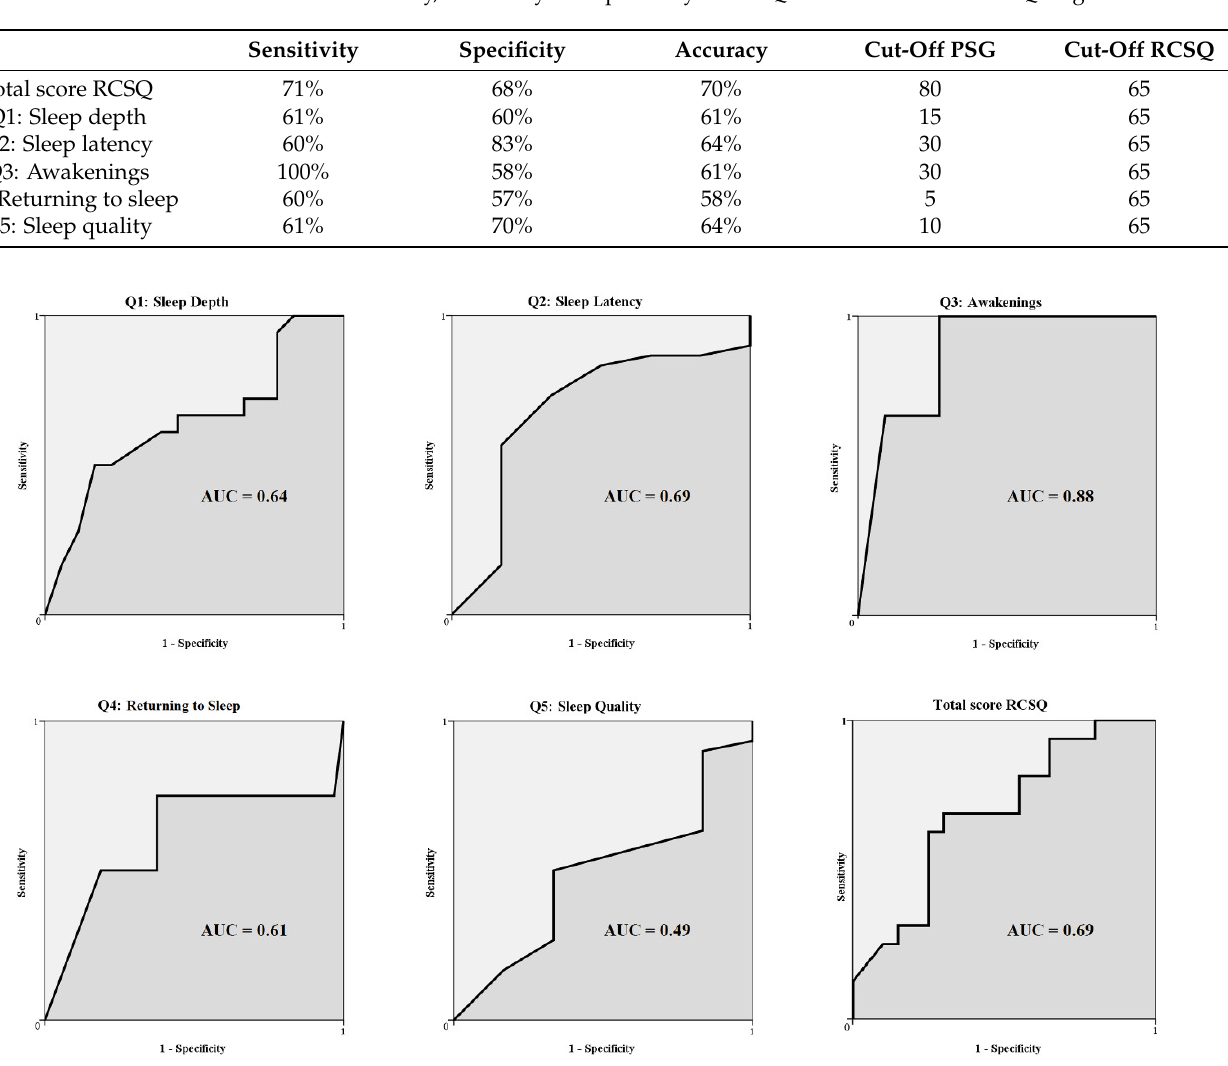
Table 4. Accuracy, sensitivity and specificity of RCSQ total scores and of RCSQ single items.